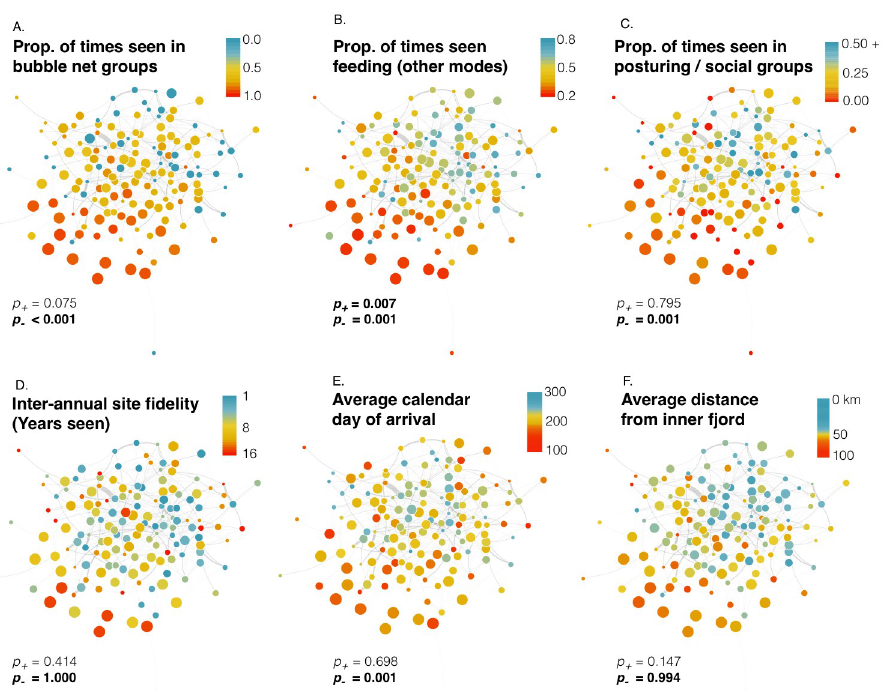
Fig 7. Network of social preferences of humpback whales ( � 5 encounters; n edges = 1,527; n whales = 136) based upon the Generalized Affiliation Index (only positive indices are displayed) and color-coded by aspects of habitat use and behaviour that were found to yield significant Assortativity Coefficients (ACs), which indicate correlation between these traits and social organization. P-values of positive ACs (affiliations) and negative ACs (avoidances) are provided below each network (see text for interpretation of significance). In all networks the placement of individuals remains the same, demonstrating related patterns in the distribution of individual traits. Vertex size reflects the number of observations of each individual. Thicker, darker edges represent statistically significant associations based upon data stream permutations (1,000 iterations). Networks built with igraph in R using the Fruchterman-Reingold